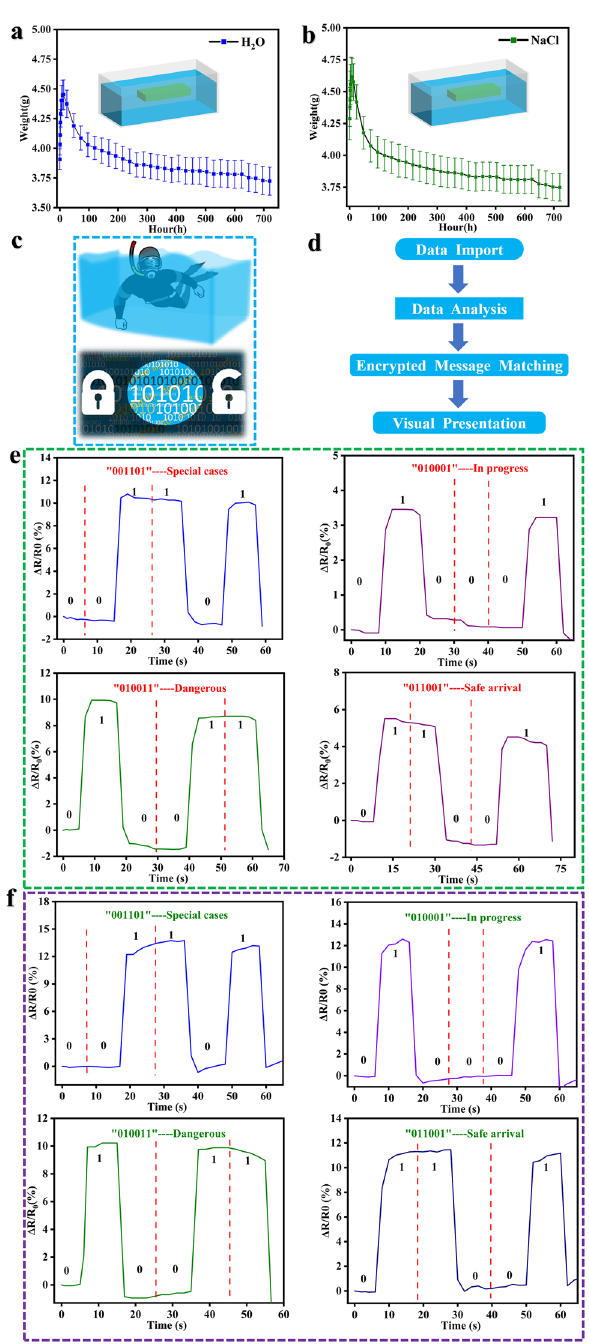
Fig. 6 PGC hydrogel for underwater sensing applications. Swell- ing behavior of PGC hydrogels in a water and b simulated seawater. c PGC hydrogels for potential applications such as underwater or encrypted communications. d Operational framework of the code- breaking system. The operation of “001101”, “010011”, “010001” and “011001” in e water and f simulated seawater,